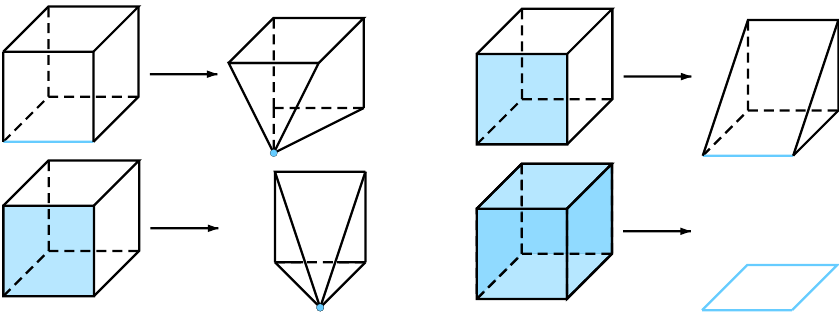
Figure 1 . (Top left:) Collapse of a curve. (Top right:) Collapse of a divisor to a curve. (Bottom left:) Collapse of a divisor to a point. (Bottom right:) Collapse of the